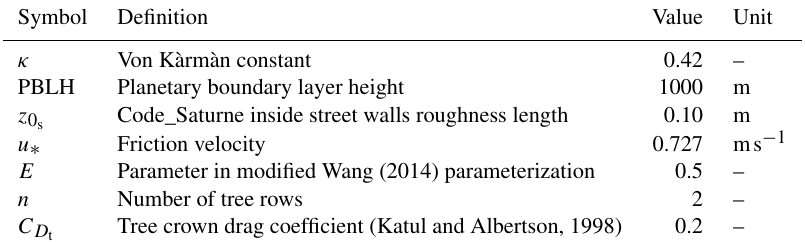
Table A2. List of parameters.